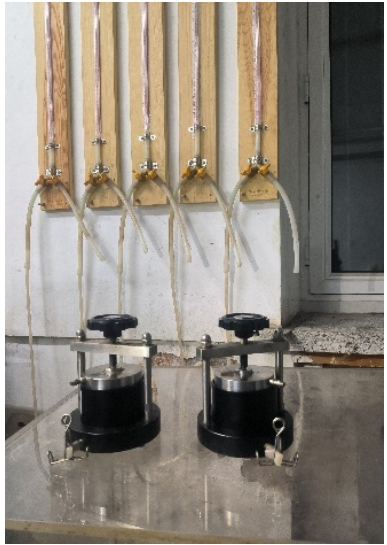
Figure 4. Falling head permeability test.